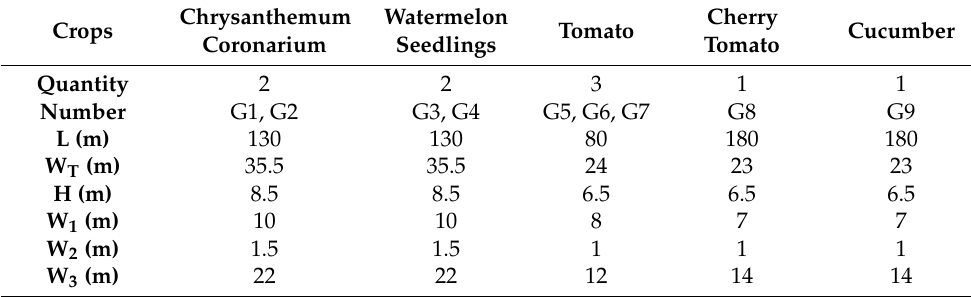
Table 1. Parameters of greenhouses.